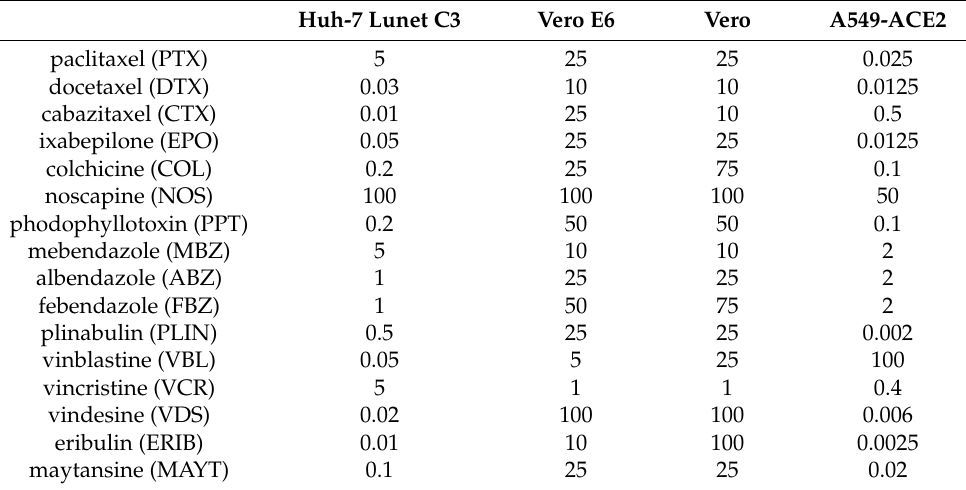
Table 1. Concentrations of clinically approved used in the infection